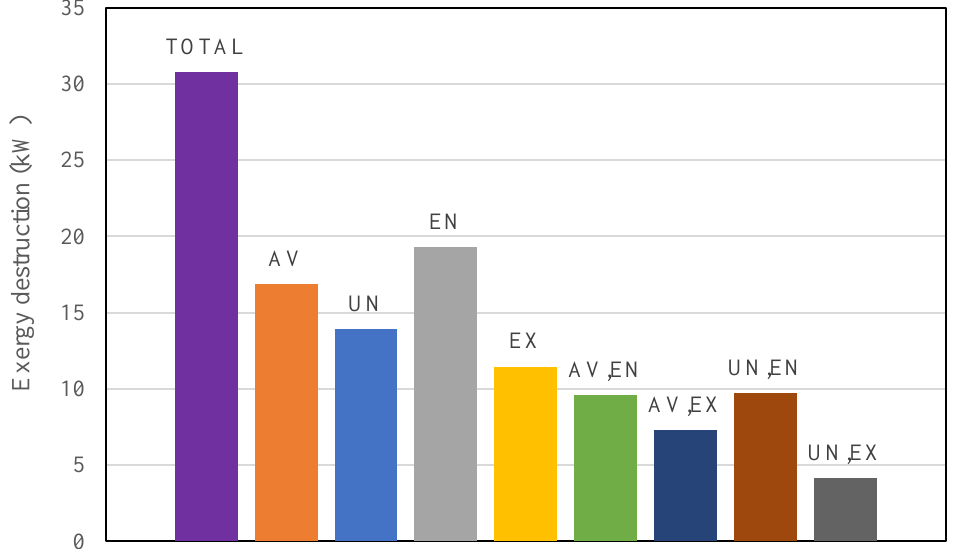
Figure 7. Total exergy destruction rate for the different parts in BORC.